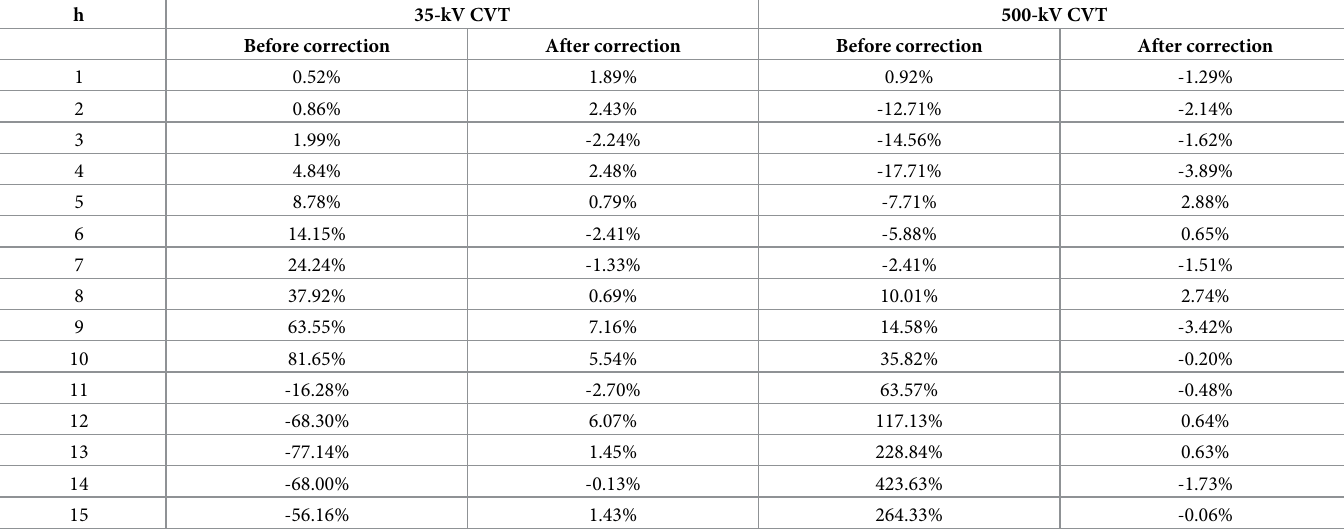
Table 15. Comparison of the harmonic measurement